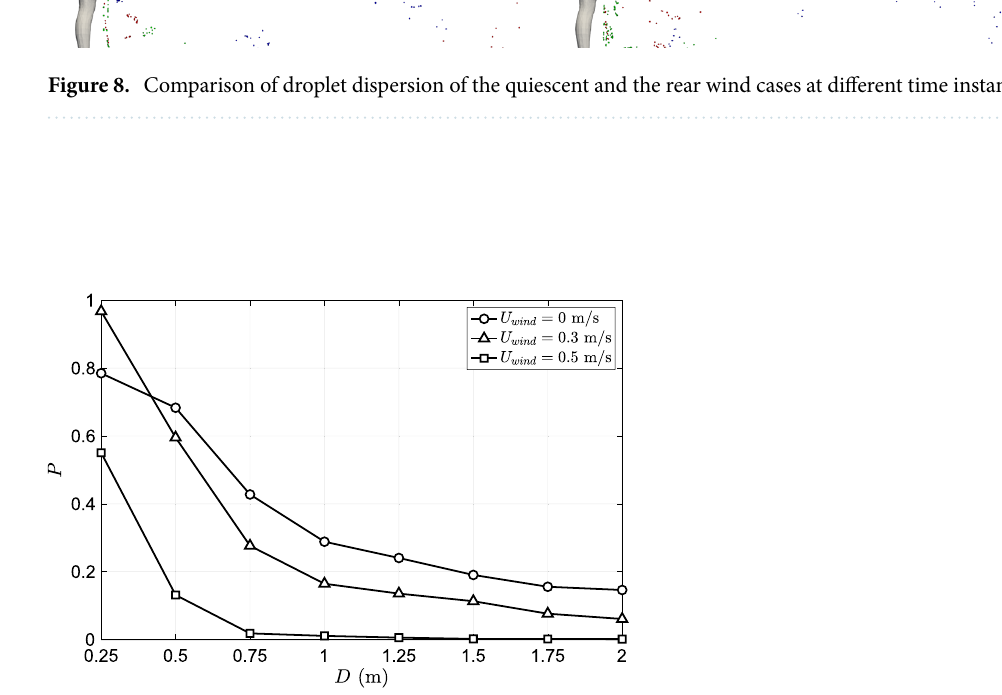
Figure 9. Probability of infection after 15 min. of exposure under different wind